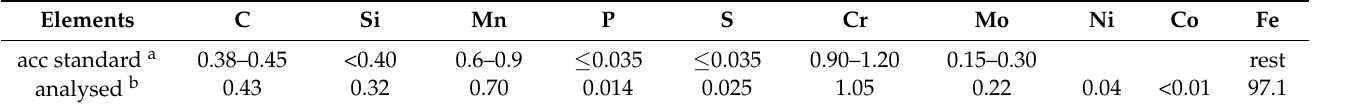
Table 1. Chemical composition of 1.7225 (42CrMo4, AISI 4042), in mass percent.